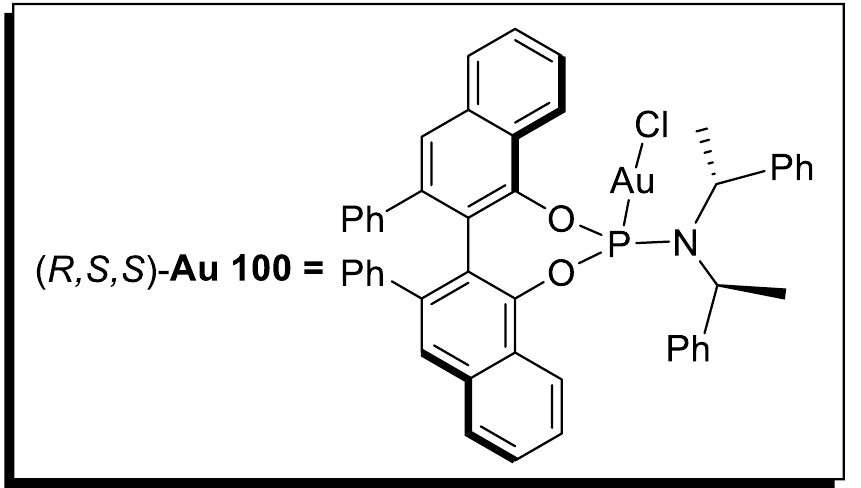
Figure 1. Structure of gold catalyst 100 reported by Varela et al. [59]. Marcote et al. reported the use of oxime derivatives as a reaction partner instead of imines in cycloaddition reactions [60]. They reported a straight forward strategy to prepare highly functionalized piperidines and piperidine-containing azabridged carbocycles via gold(I)-catalyzed [2+2+2] cycloaddition between allenes and C- and O-tethered oximes. Piperidine derivative 104 was obtained with complete stereoselectivity ( cis isomer) in an excellent yield (91%) from configurationally E pure O-tethered oxime 103 and oxazolidone substituted allene 102 , while cycloaddition of the allenyl ether 102 with C -tethered alkenyl oxime 105 resulted in the highest yielded tropane derivative 106 (94%) by loading 5 mol% phosphite gold catalyst 98 in the presence of 4Å MS in DCM (Scheme 31).